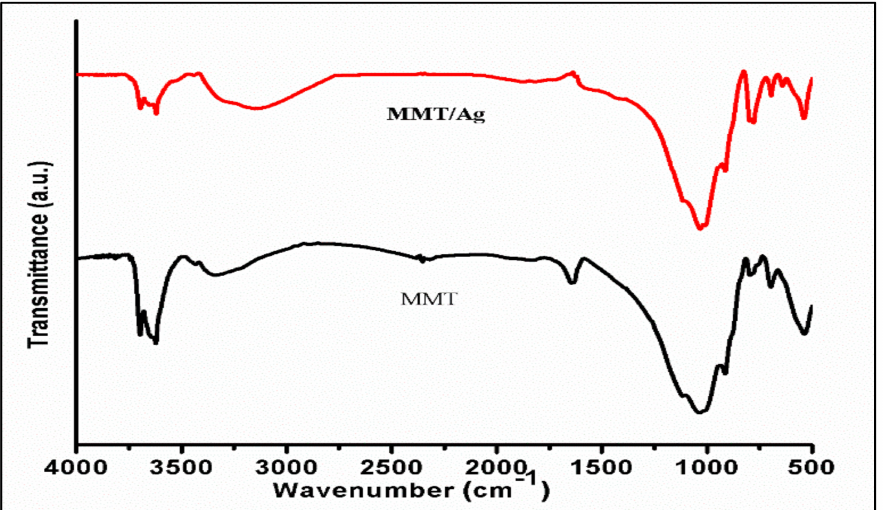
Figure 6. FTIR spectra of MMT and MMT/Ag